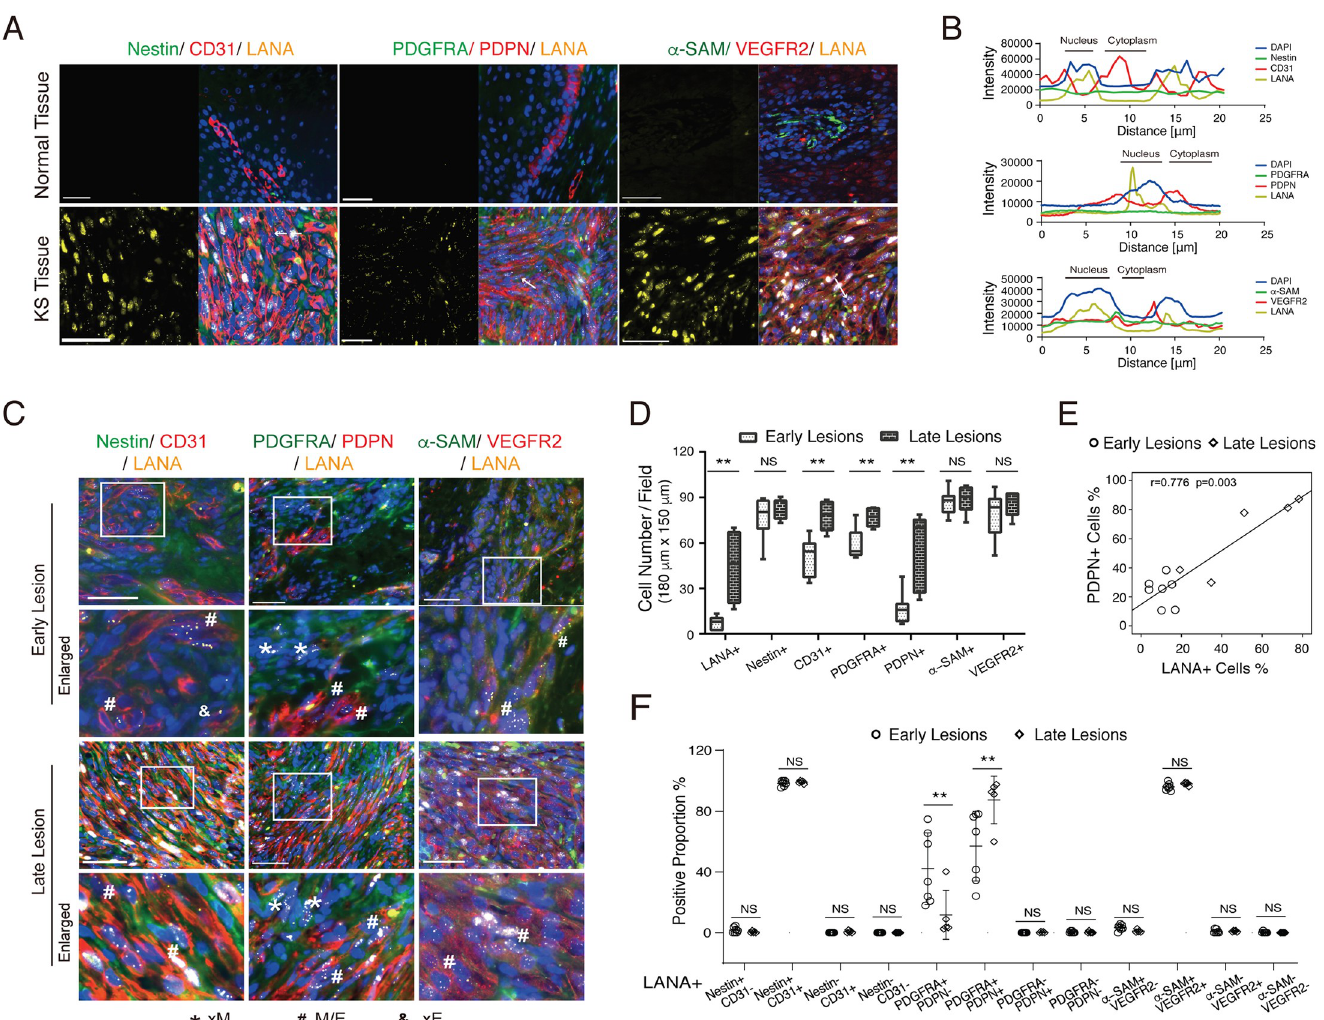
Fig 1. Co-expression of mesenchymal and endothelial markers in KS tissue. (A) Representative immunofluorescence images of AIDS-KS lesion tissues (lower) and their adjacent normal skin tissues (upper) stained with antibodies against mesenchymal (Nestin, PDGFRA, or α -SAM in green), endothelial (PDPN, CD31 or VEGFR2 in red), and KSHV (LANA in yellow) markers. The nuclei were counterstained with Hoechst 33342 (blue). Scale bars, 50 μ m. Images of each individual channel for mesenchymal, endothelial and KSHV marker, respectively, are shown in S1 Fig. ( B) Triple labeling for mesenchymal, endothelial, and KSHV markers, demonstrating the colocalization of these three fluorescent signals in the same KS tumor cell, as revealed by the plot of fluorescence intensity profiles across a white arrow in panel A. (C) Co-expression of mesenchymal (Nestin, PDGFRA, and α -SAM), endothelial (PDPN, CD31, and VEGFR2), and KSHV (LANA) markers in KS early (patch and plaque) and late lesions (nodular). Boxed areas are enlarged. Scale bar, 50 μ m. ( D) Number of LANA, Nestin, CD31, PDGFRA, PDPN, α -SAM, and VEGFR2 positive cells was counted from 4–6 individual fields (180 μ m x 150 μ m) composed mostly of spindle tumor cells and vessels in KS early (n = 7 samples) or late lesions (n = 5 samples). Numbers were compared by Chi-2 test. ( E) Spearman’s test shows a correlation between LANA expression and cells positive for PDPN in early and late KS tumors. ( F) Percentage of Nestin-/CD31-, Nestin+/CD31-, Nestin+/CD31+, Nestin-/CD31+ and PDGFRA-/PDPN-, PDGFRA+/PDPN-, PDGFRA+/PDPN+, PDGFRA-/PDPN+, and α -SAM-/VEGFR2-, α -SAM+/VEGFR2-, α -SAM+/VEGFR2+, α -SAM-/VEGFR2+ cells in LANA+ spindle tumor cells in early or late KS lesions.